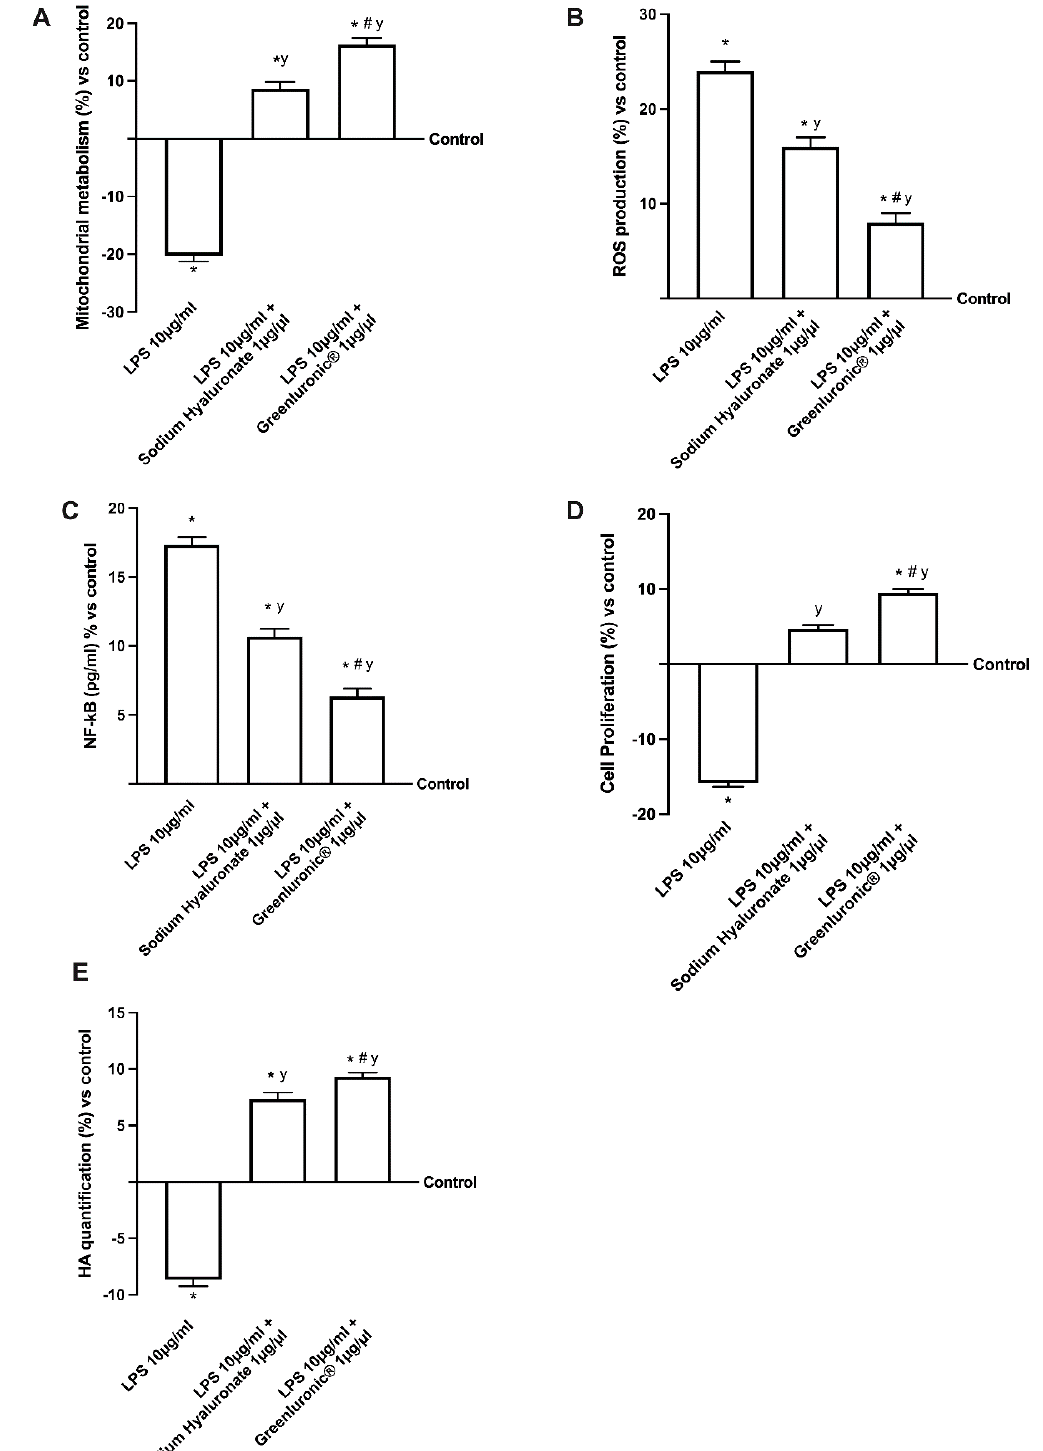
Figure 6. GreenIuronic ® and Sodium Hyaluronate effects on T/C-28a2 cells during OA conditions. In ( A ) mitochondrial metabolism tested by MTT test; in ( B ) ROS production; in ( C ) NFkB analysis by ELISA test; in ( D ) proliferation analysis by crystal violet; and in ( E ) HA quantification by ELISA kit. Data are mean ± SD of five independent experiments performed in triplicates expressed as a percentage compared to control (0% line). * p < 0.05 vs. control; y p < 0.05 vs. 10 µg/mL of LPS; # p < 0.05 vs. Sodium Hyaluronate 1 µg/µL.